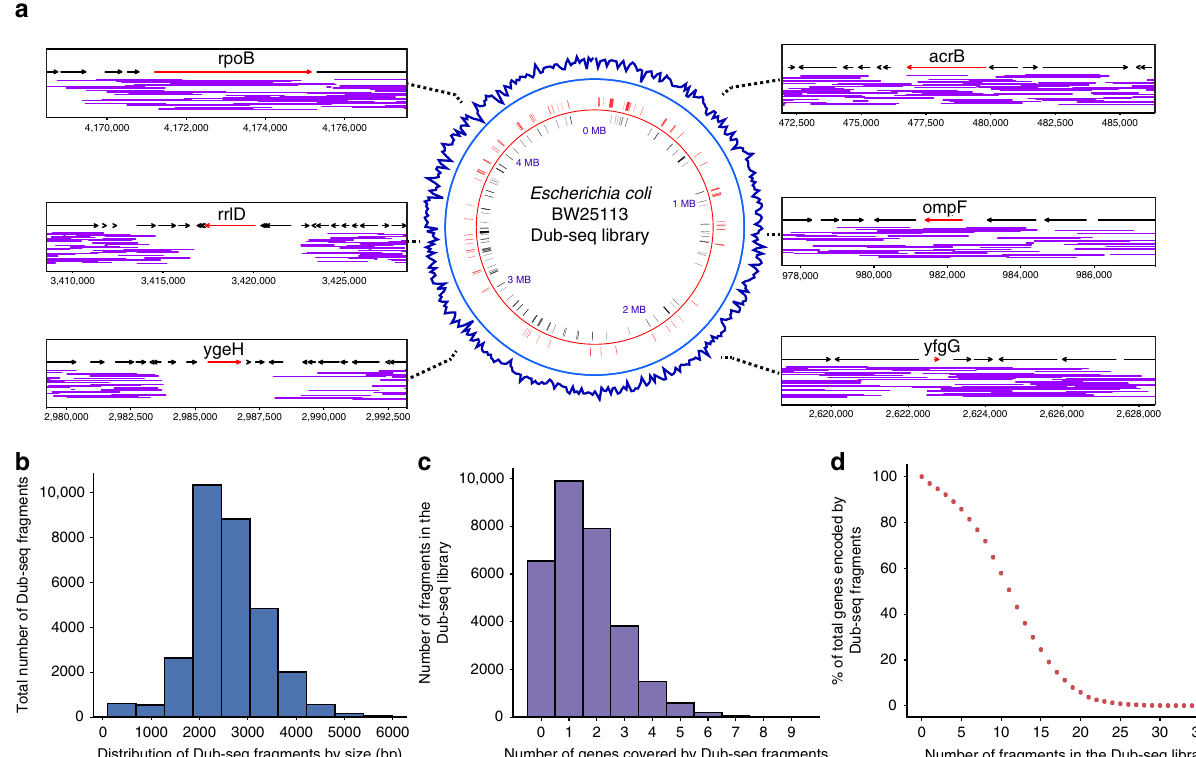
Fig. 2 E. coli dual-barcoded shotgun expression library sequencing (Dub-seq) library characterization. a Center: genomic coverage of the E. coli BW25113 Dub-seq library in 10 kb windows (blue track). Black and red line-tracks represent genes essential for viability when deleted 5 that are encoded on the negative and positive strands, respectively, and are covered in the Dub-seq library. Left and right: regions of the E. coli chromosome covering acrB , ompF , yfgG , ygeH , rrlD , and rpoB . Each purple line represents a Dub-seq genomic fragment (the y axis is random). b The fragment insert size distribution in the E. coli Dub-seq library. c The distribution of number of genes that are completely covered (start to stop codon) per genomic fragment in the E. coli Dub-seq library. d Cumulative distribution plot showing the percentage of genes in the E. coli genome ( y axis) covered by a number of independent genomic fragments ( x axis). Source data are provided as a Source Data fi